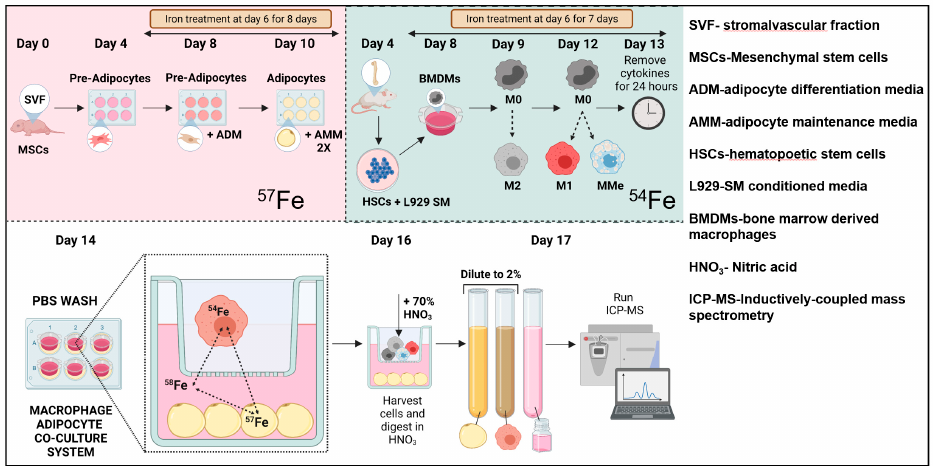
Figure 5. Schematic describing the procedure and workflow for isotopic iron labeling co-culture system.